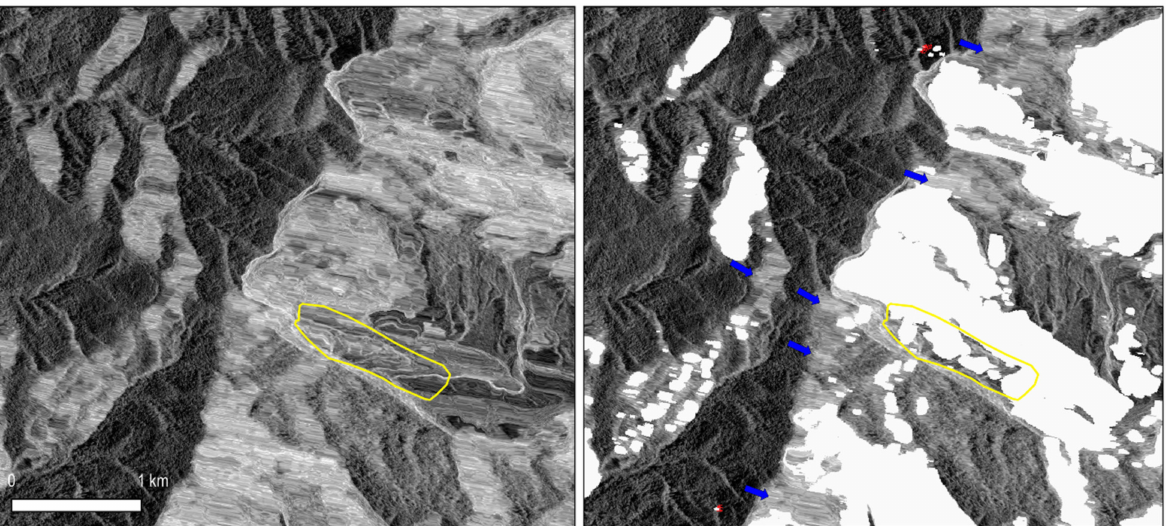
Figure 10. ( Left ) Slopes within the layover zones appear as brighter and stretched pixels in the post- event X-band CSK σ 0 image. In comparison, slopes in non-layover areas show typical speckle textures. Yellow polygon is the 7 June 2017 landslide patch. ( Right ) After applying the layover-shadow mask (white and red pixels), some severely stretched patterns remain unmasked (blue arrows) possibly due to errors in DEM or incorrect prediction in the SAR geometric distortion